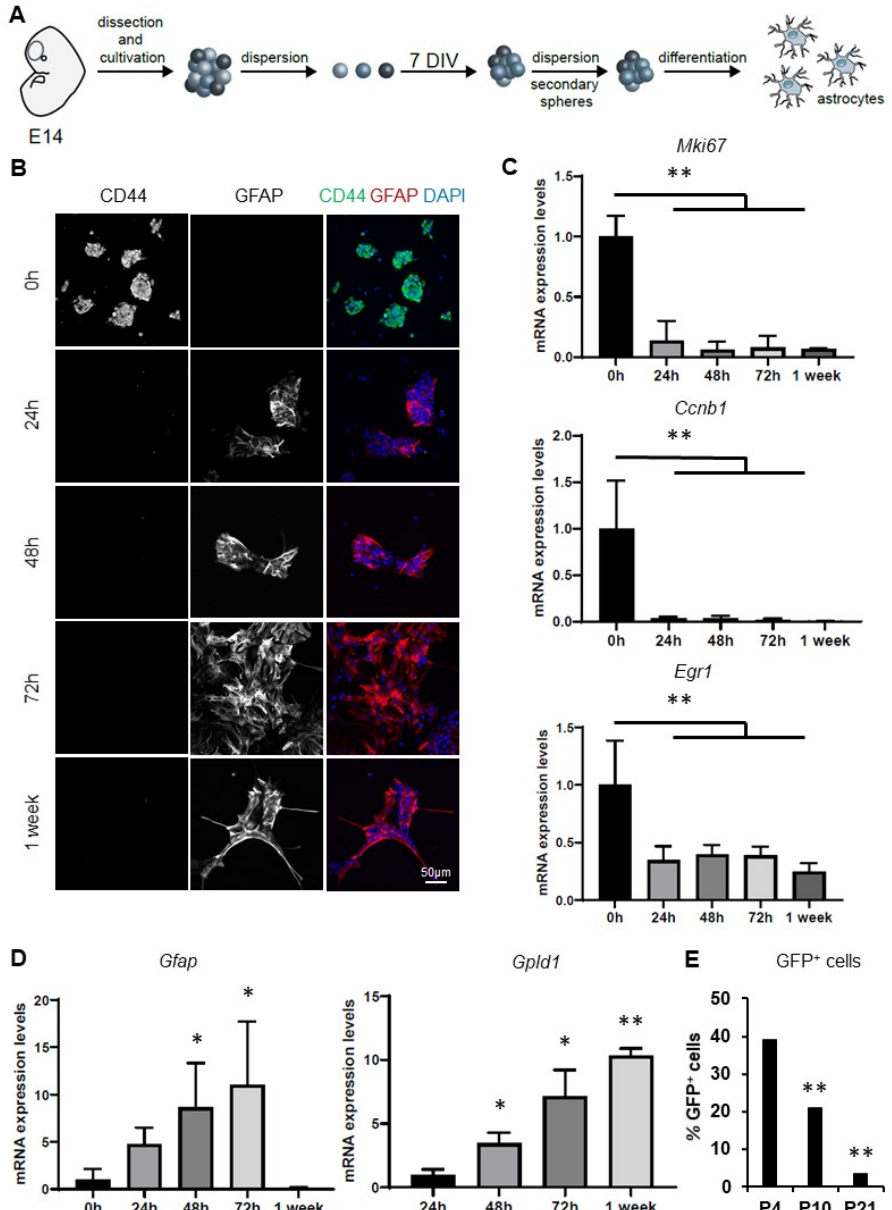
Figure 1. In vitro differentiation of neurospheres (NSPs) into astrocytes. ( A ) Schematic showing the in vitro cellular model of primary neurospheres (NSPs) derived from NSCs isolated from the ventricular zone at embryonic day-14 (E14) of the mouse embryos and the subsequent passages to differentiate them into astrocytes. ( B ) Immunostaining analyses of CD44 (green) and GFAP (red) of NSPs and differentiating astrocytes obtained from primary murine cultures of NSPs cultivated under proliferation conditions (DMEM F12, 1% B27 without vitamin A, antibiotics and 20 ng/mL EGF) or differentiated into astrocytes (DMEM, 10% FBS and antibiotics) for 24 h, 48 h, 72 h, and 1 week. Nuclei were counterstained with DAPI (in blue). Scale bar: 50 µ m. ( C , D ) RT-qPCR analyses showing mRNA expression levels of ( C ) the cell cycle genes Mki67 and Ccnb1 , the NSC marker Egr1 , ( D ) the astrocytic marker Gfap, and the astrocyte-enriched gene Gpld1 . Results are expressed as mean ± standard deviation. Each time point is shown relative to a specific condition set to 1. * p < 0.05; ** p < 0.01, n ≥ 4. ( E ) Quantification of GFP + cells from mouse forebrain cell suspensions of hGFAP:: eGFP transgenic mice by FACS at postnatal day 4 (P4), P10, and P21. Bars represent the mean ± SEM. ** p < 0.01, n =